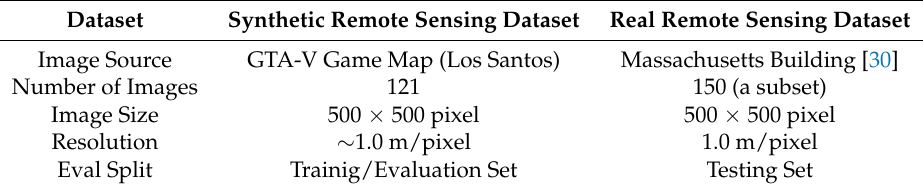
Table 1. Statistics of our experimental datasets. We first train our model on the synthetic remote sensing dataset (GTA-V game map) and then run evaluation on the real remote sensing dataset (Massachusetts